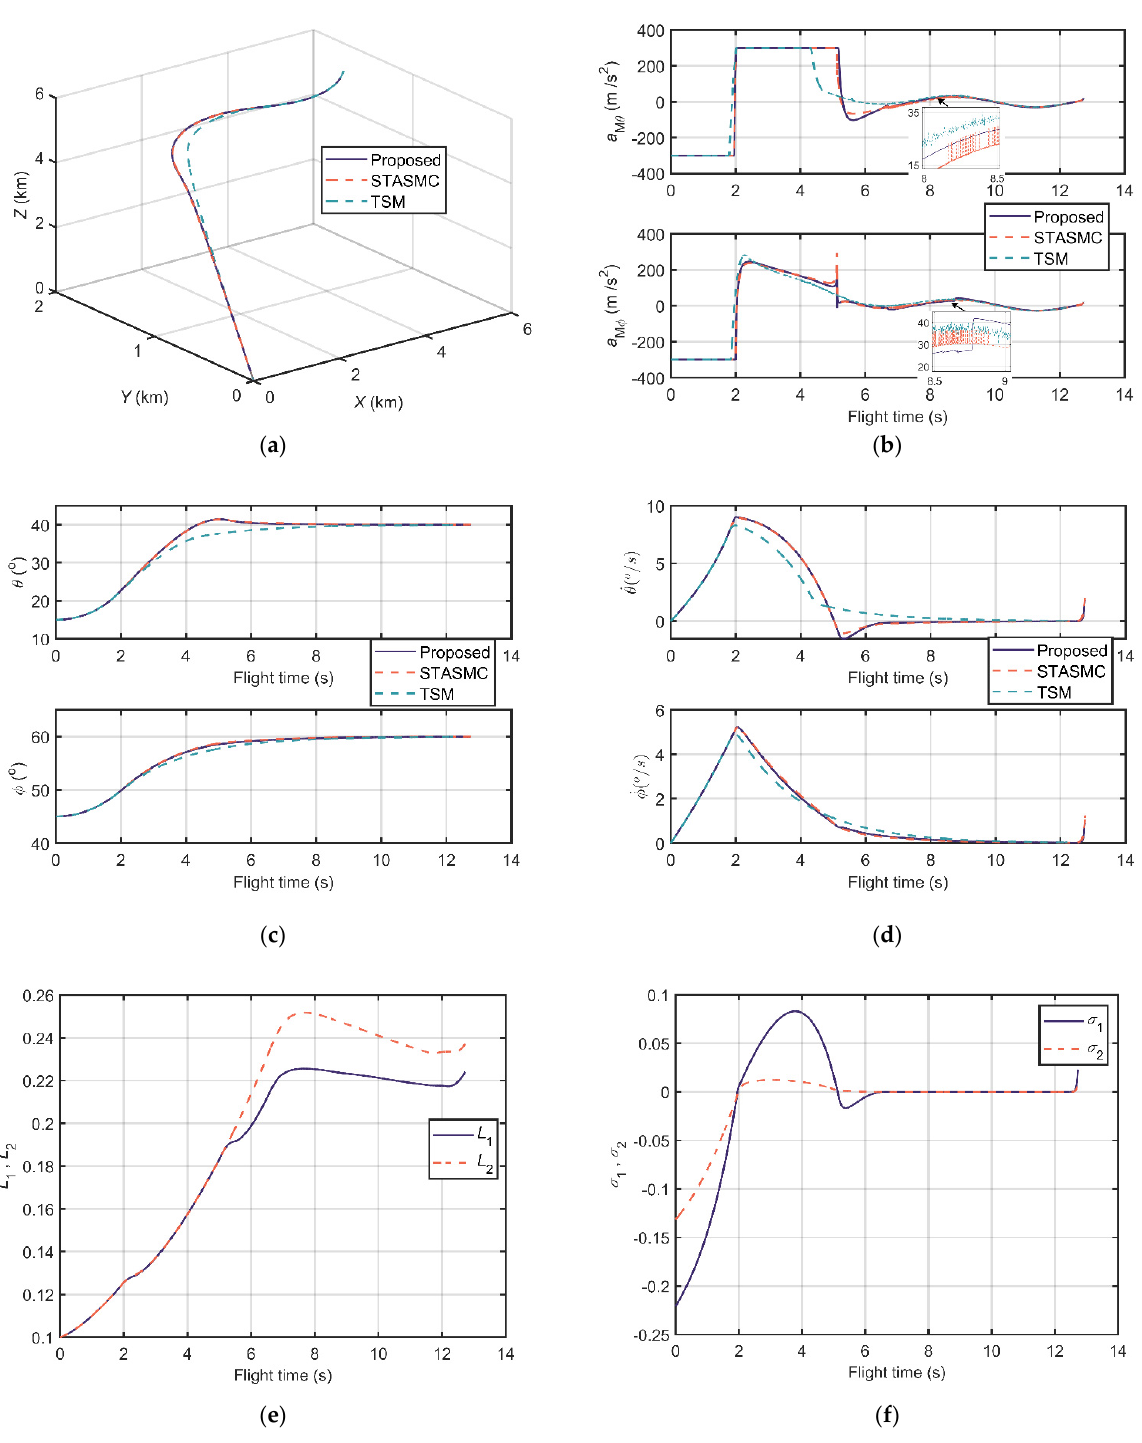
Figure 8. Comparison results of scenario 1: ( a ) Relative distance trajectories; ( b ) Output accelerations of guidance loops; ( c ) LOS angles; ( d ) LOS angular rates; ( e ) The adaptive STA gains; and ( f ) The sliding manifold.